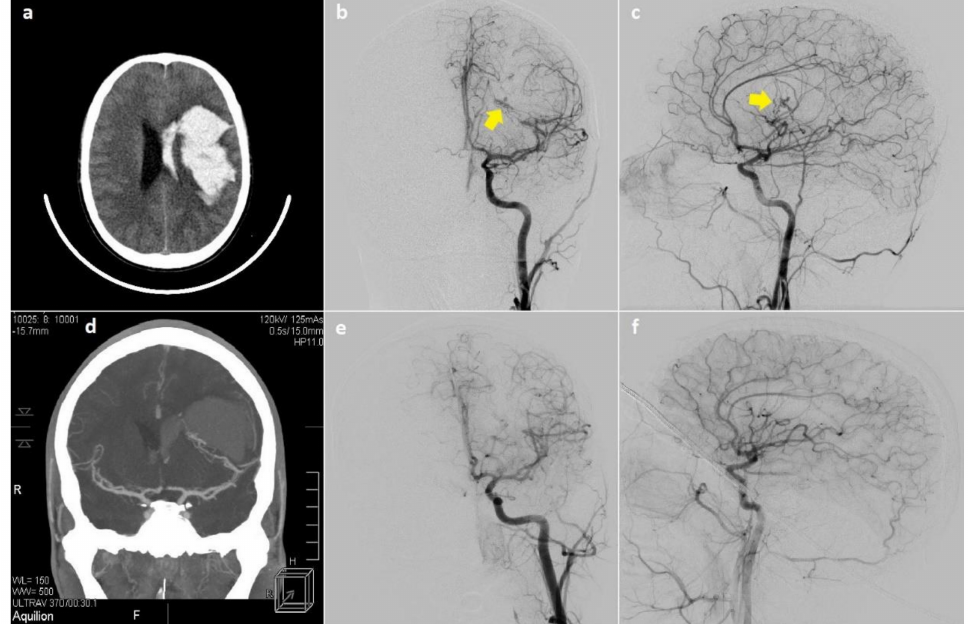
Figure 2. Imaging studies of the 16-year-old male patient. CT scan revealed intracerebral and intraventricular hemorrhage in the left hemisphere ( a , d ). Preoperative angiography demonstrated Spetzler-Martin III, arteriovenous malformation in the left temporal lobe (yellow arrows) ( b , c ). DSA examination performed 1.5 years after surgery showed complete excision of the malformation ( e , f